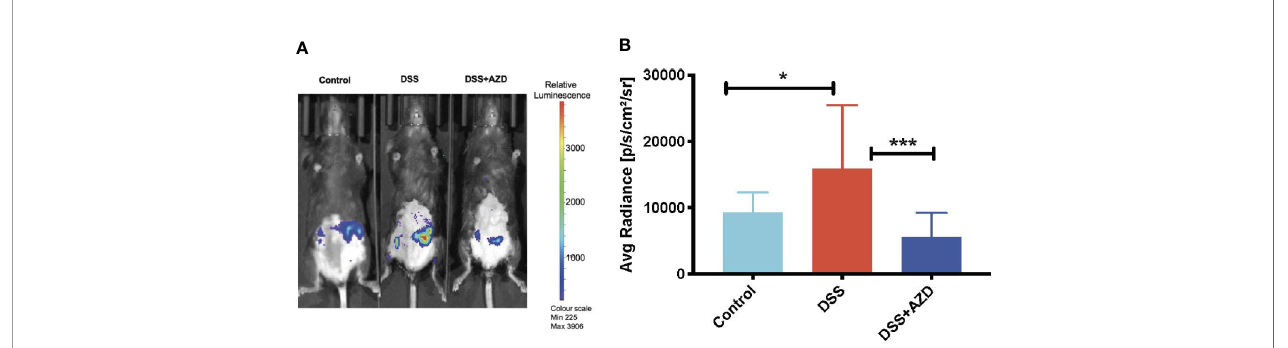
FIGURE 4 | In vivo bioluminescent imaging of luminol oxidation in mice. Mice were randomly divided into three treatment arms over 9 days i) vehicle group given normal drinking water and peanut butter without drug; ii) dextran sodium sulfate (DSS) group given 2% w/v DSS in drinking water and peanut butter without drug; iii) DSS+AZD3241 given 2% w/v DSS in drinking water and AZD3241 @ 30 mg/kg in peanut butter. At day 10, mice were anesthetized, maintained at 1.5% – 2% v/v iso fl urane and injected with 100 µl of 475 mM luminol through subcutaneous (SC) route in the scruff and immediately imaged using IVIS ® SpectrumCT (PerkinElmer). (A) Representative in vivo images of bioluminescence signal in vehicle control (left), 2% w/v DSS (middle) and 2% w/v DSS+AZD3241 right. (B) Quanti fi cation of regions of interests (ROIs) depicting highest bioluminescence signal intensity. Right side vertical scale is indicative of relative bioluminescence radiance shown as a heat map with relative radiance scale. Data is representative of n=4/group presented as radiance measured in units photons/sec/cm 2 /sr. *Different to the control, (p = 0.01); ***Different to the DSS+AZD3241 ( p < 0.001). AZD3241 is abbreviated to AZD in this fi